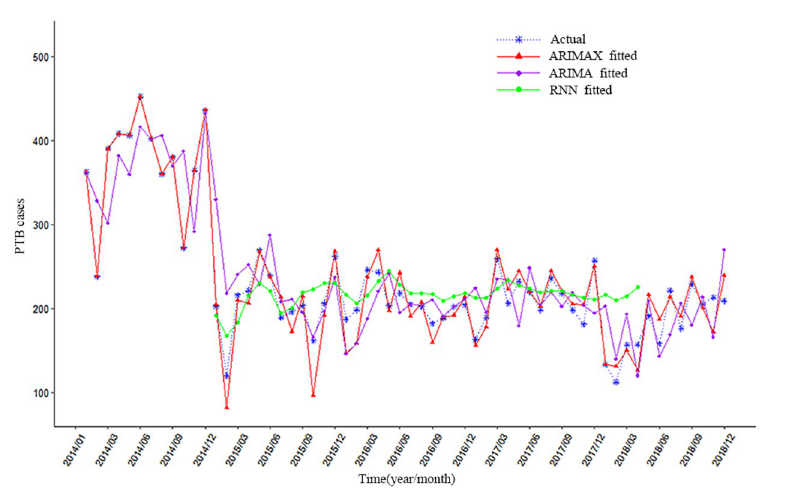
Fig 8. The fitting results of ARIMA, ARIMAX, and RNN